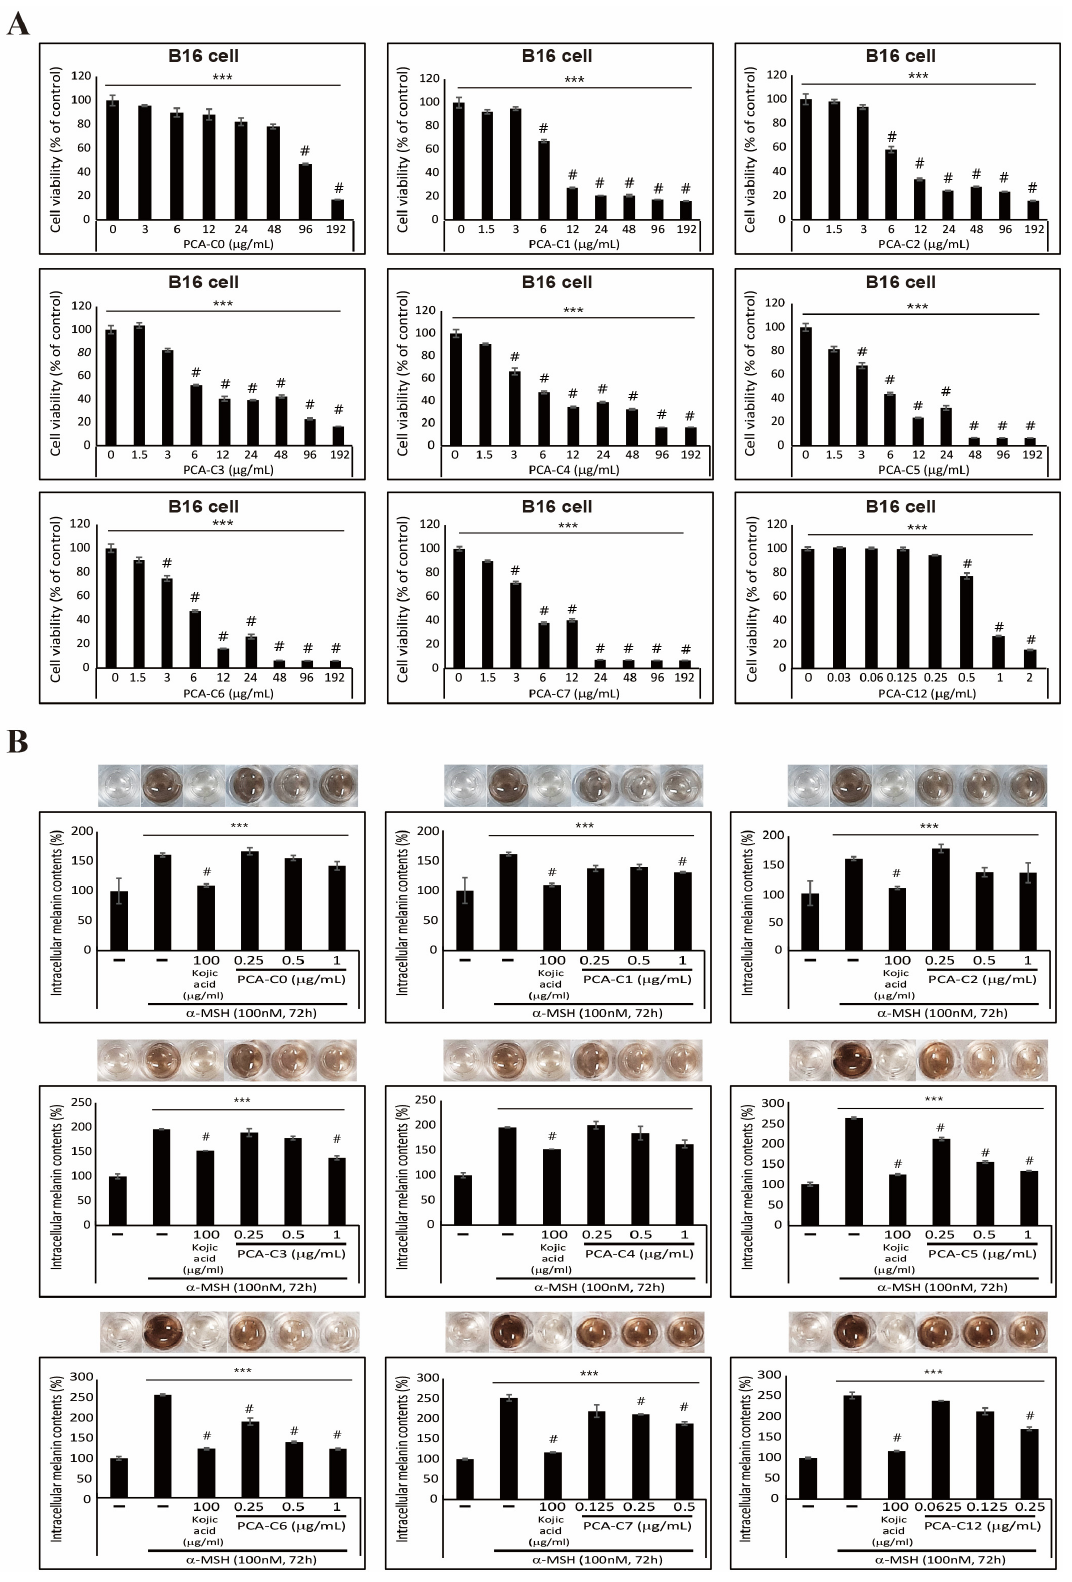
Figure 2. PCA derivatives inhibit α -MSH-induced melanin synthesis in B16 melanoma cells. ( A ) Cell viability results showed the inhibition of B16 cell proliferation after treatment with an increased PCA-C(X) concentration for 24 h. The data represent three independent tests. # p <